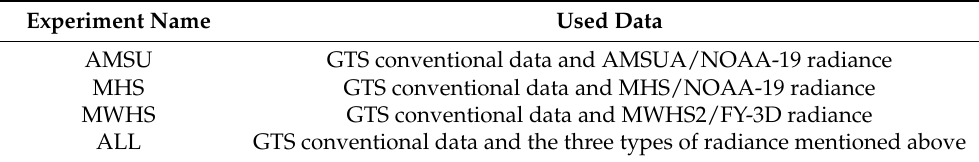
Table 1. Experimental designment.